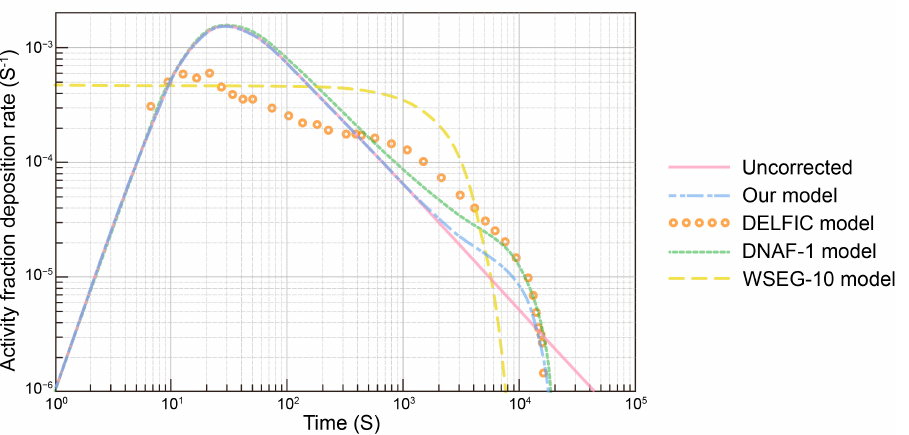
Figure 3. Comparison of settling rate diffusion factors for different models at an explosion equivalent of 1 kiloton.